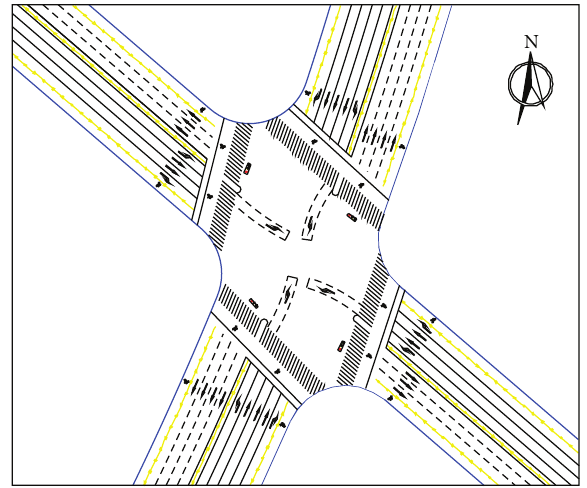
Figure 3: Research